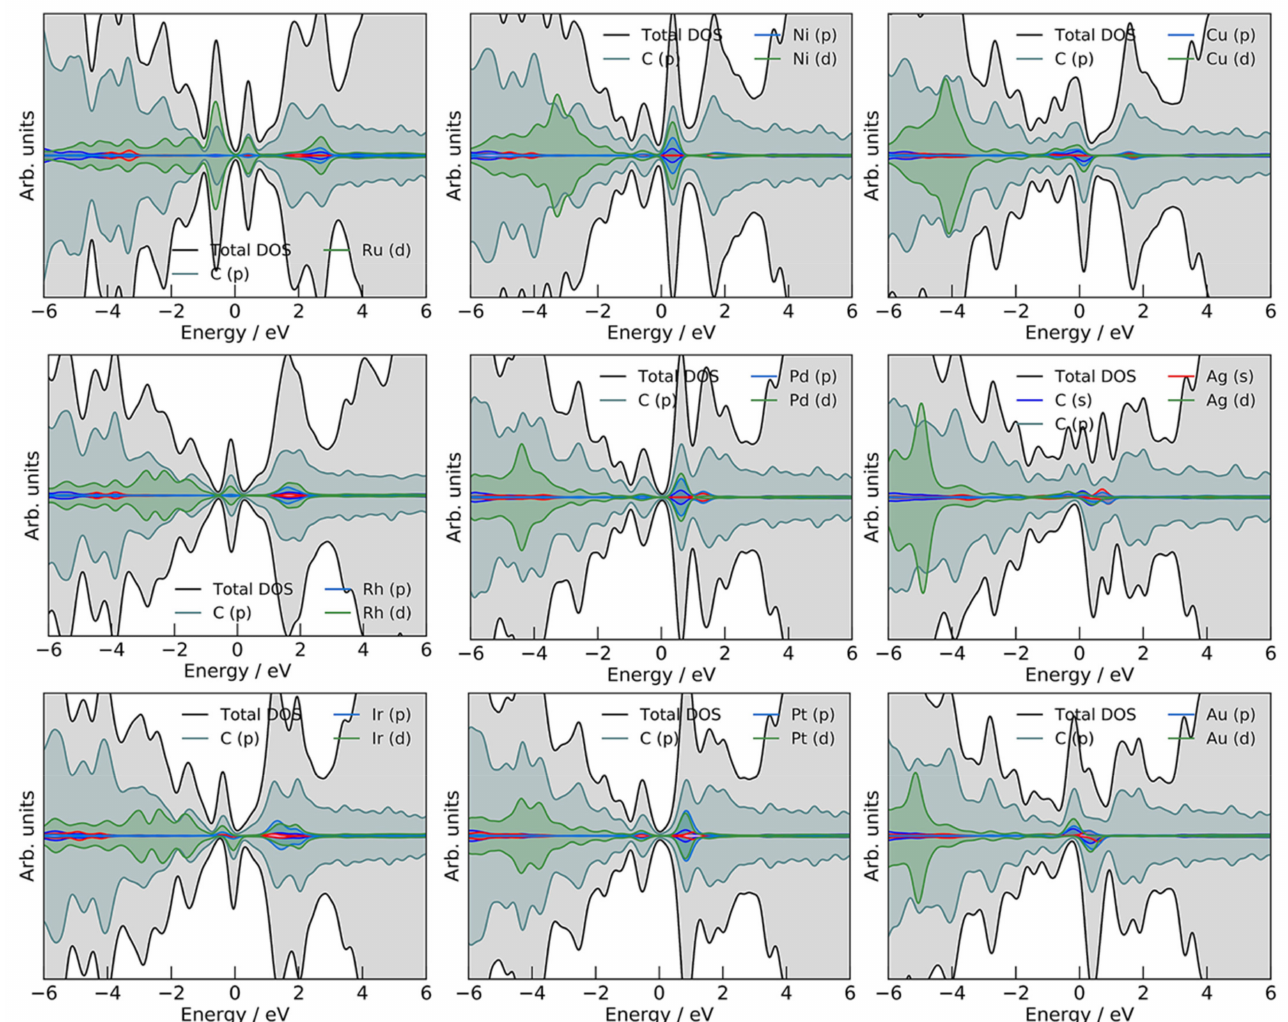
Figure 3. Densities of states for the investigated M@vG systems. Total DOS, carbon, and metal states are given. Plots were generated using the SUMO Python toolkit for VASP [37], and the energy scale is referred to the Fermi